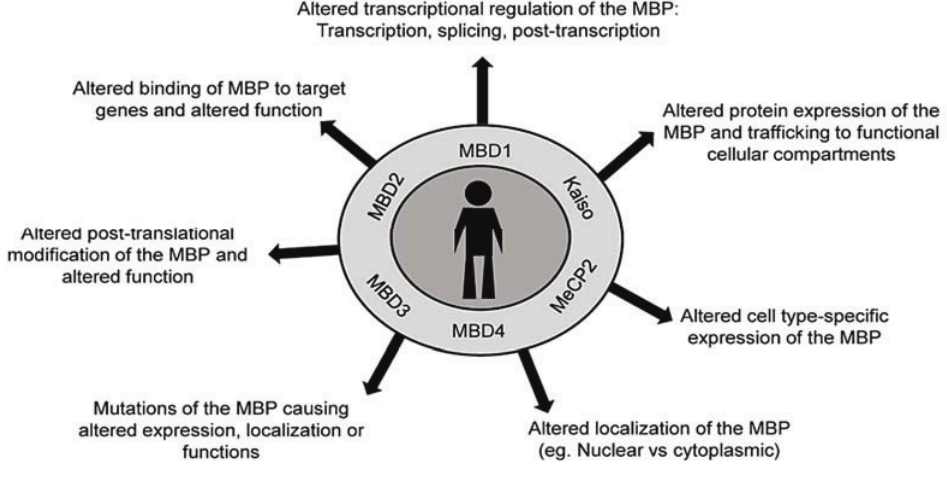
Figure 3. The ways alterations in methyl binding proteins (MBPs) cause human diseases. Major methyl binding proteins (MBPs) include Methyl binding domains 1, 2, 3, 4, (MBD1, MBD2, MBD3, MBD4), Methyl CpG binding protein 2 (MeCP2) and Kaiso proteins.